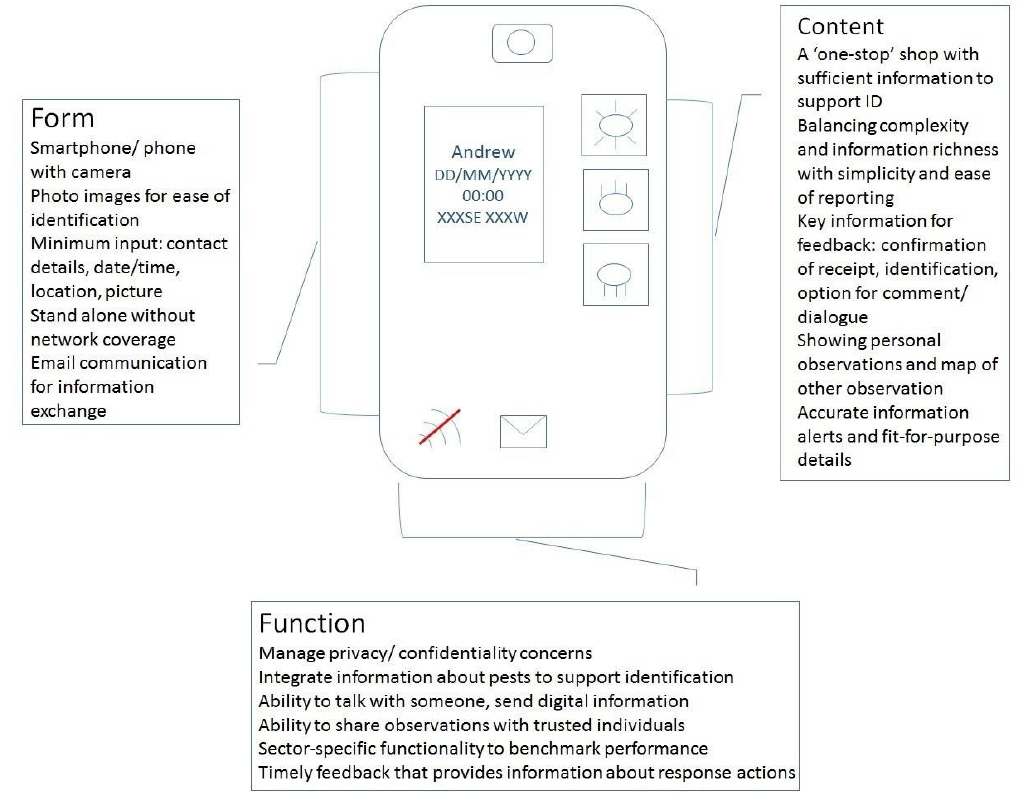
Figure 3. Information from users transferred to a generic model of form, content and function suitable as a basic set of conditions to meet users’ needs .